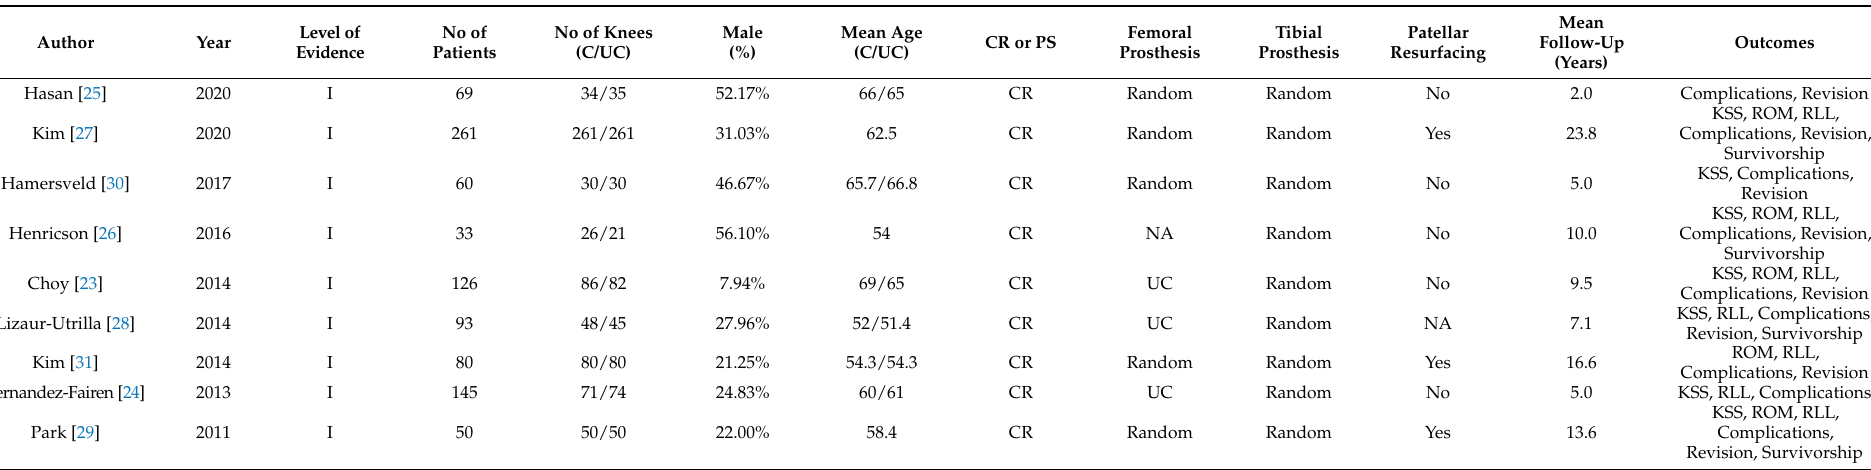
Table 1. Characteristics of the studies included in the meta-analysis. Abbreviations: C: cemented; UC: uncemented; CR: cruciate-retaining; PS: posterior-stabilized; KSS: Knee Society Score; ROM: range of motion; RLL: radiolucent line; NA: not